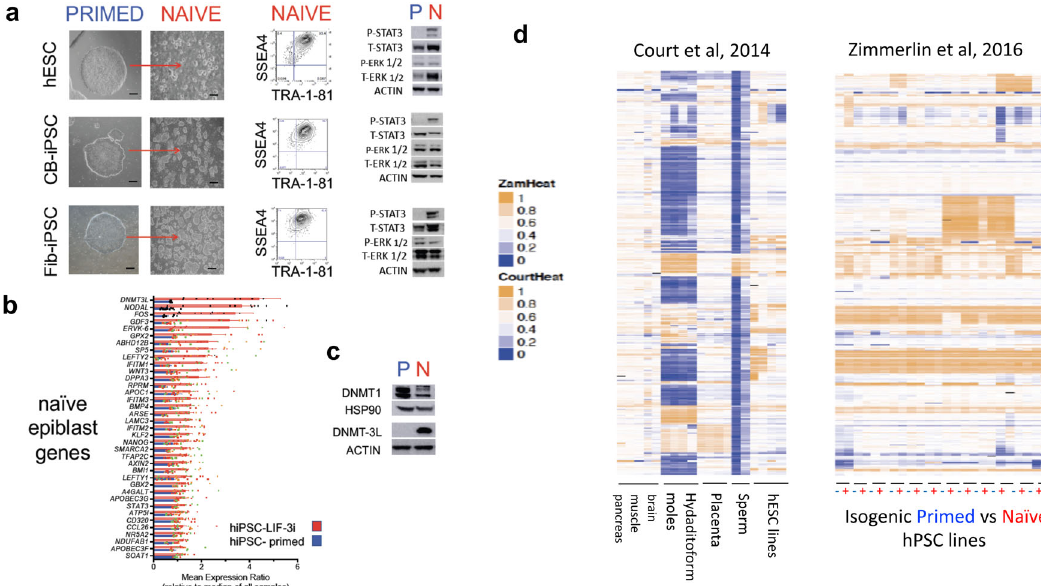
Fig. 5 Chemical reversion of conventional primed hPSC with a tankyrase/PARP inhibitor promotes stable rewiring to a human preimplantation epiblast-like state with intact epigenomic imprints. The TIRN method is a two-step culture system 109,111 comprised of one brief adaptation step of conventional hPSC with LIF and fi ve small molecules (LIF-5i) that includes XAV939 (tankyrase/PARP inhibition), CHiR99021 (GSK3 β inhibition), PD0325901 (MEK inhibition), forskolin (adenylate cyclase activation), and purmorphamine (Hedgehog signaling activation); followed by continuous, stable culture in only LIF/XAV939/CHIR99021/PD0325901 (LIF-3i) for at least 30 passages. This tankyrase/ PARP inhibitor-mediated modi fi cation of the classical LIF-2i method has been validated to stably revert over 30 hPSC lines, and is independent of genetic donor background 109,111 . a (Left panels) Three representative hPSC lines 109,110 (RUES1 hESC, cord blood (CB)-hiPSC 6.2, and fi broblast ( fi b)-hiPSC C.2 are shown in their starting primed (i.e., E8 medium; PRIMED) conditions, and 6 – 10 passages post culture in continuous TIRN-reverted (NAÏVE) conditions 109,111 . Monolayer bFGF-dependent hPSC colonies in primed conditions became tolerant to bulk single-cell passaging and acquired a typical dome-shape morphology following TIRN reversion. (Middle panels) TIRN-hPSC retained strong expression of TRA-1 – 81 and SSEA4 surface antigens by fl ow cytometry. (Right panels) Western blot analyses in these three primed (P) and TIRN (N) lines demonstrated that TIRN-hPSC acquired de novo expression of phosphorylated STAT3 and reduced ERK1/2 phosphorylation. b